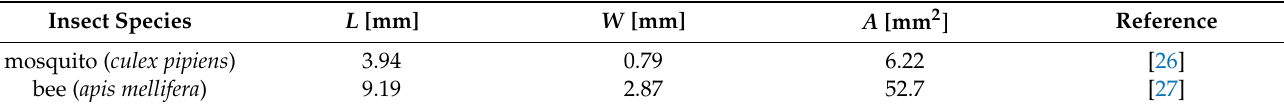
Figure 1. Insect model consisting of a set of point scatterers. The red circle represents the insect’s body, whereas the blue circles represent its wings. Table 1. Wing dimensions of the simulated